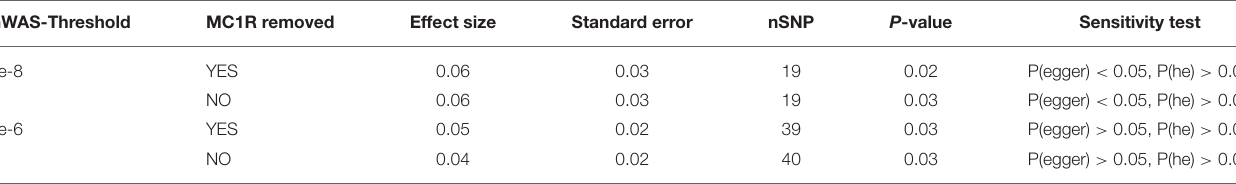
TABLE 3 | Inverse-Variance Weighted (IVW) Mendelian Randomization (MR) results for melanoma in females (exposure) and endometriosis (outcome).